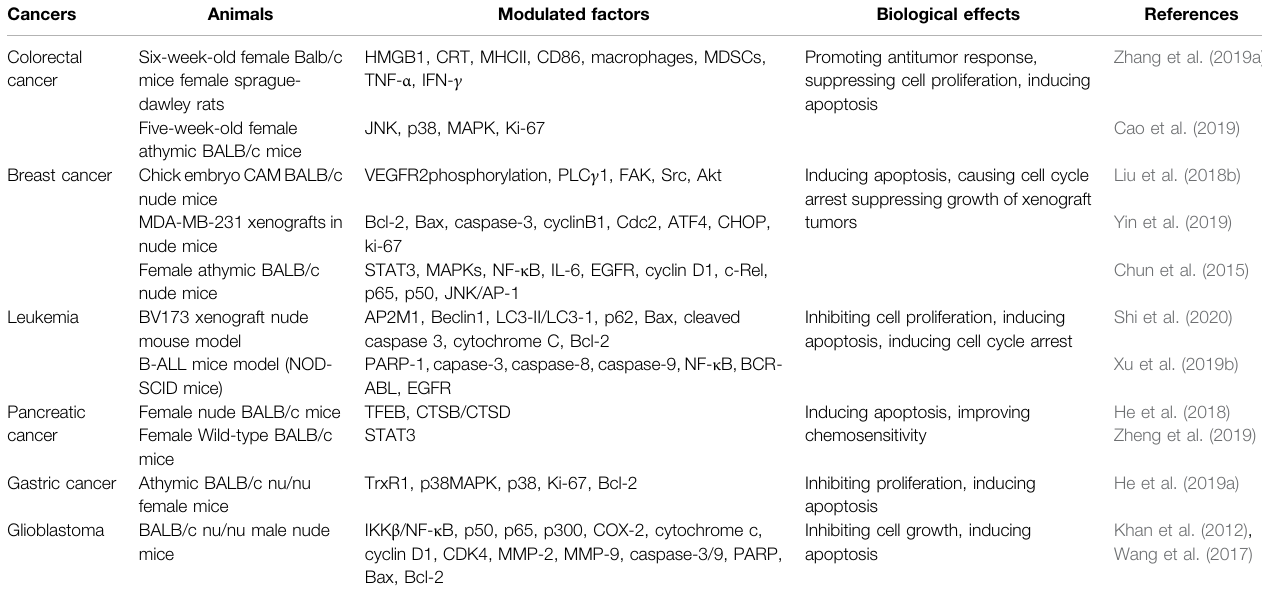
TABLE 2 | The anticancer activities and the underlying mechanisms of alantolactone in vivo